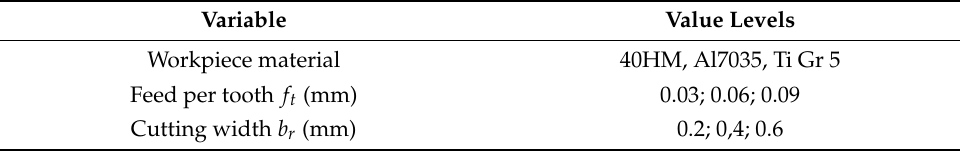
Table 2. Input variables used in the